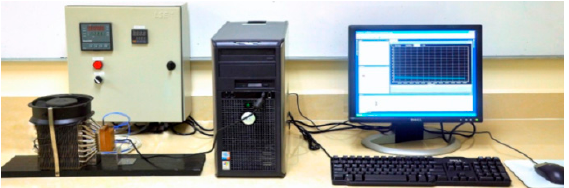
Figure 1. In-house thermal cycling test system.